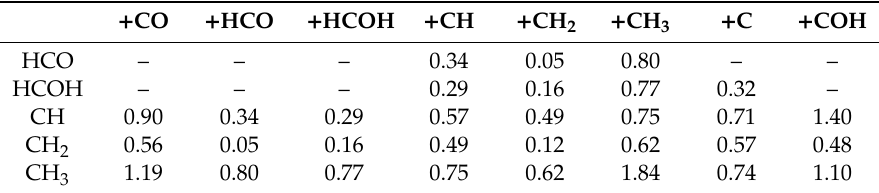
Table 2. Activation energies of the coupling reactions.